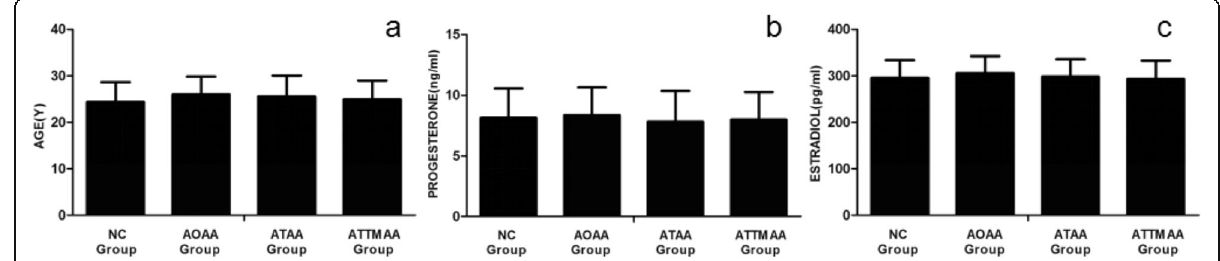
Fig. 2 Age, progesterone, and estradiol in the NC group, AOAA group, ATAA group, and ATTMAA group. a age; b progesterone; c estradiol